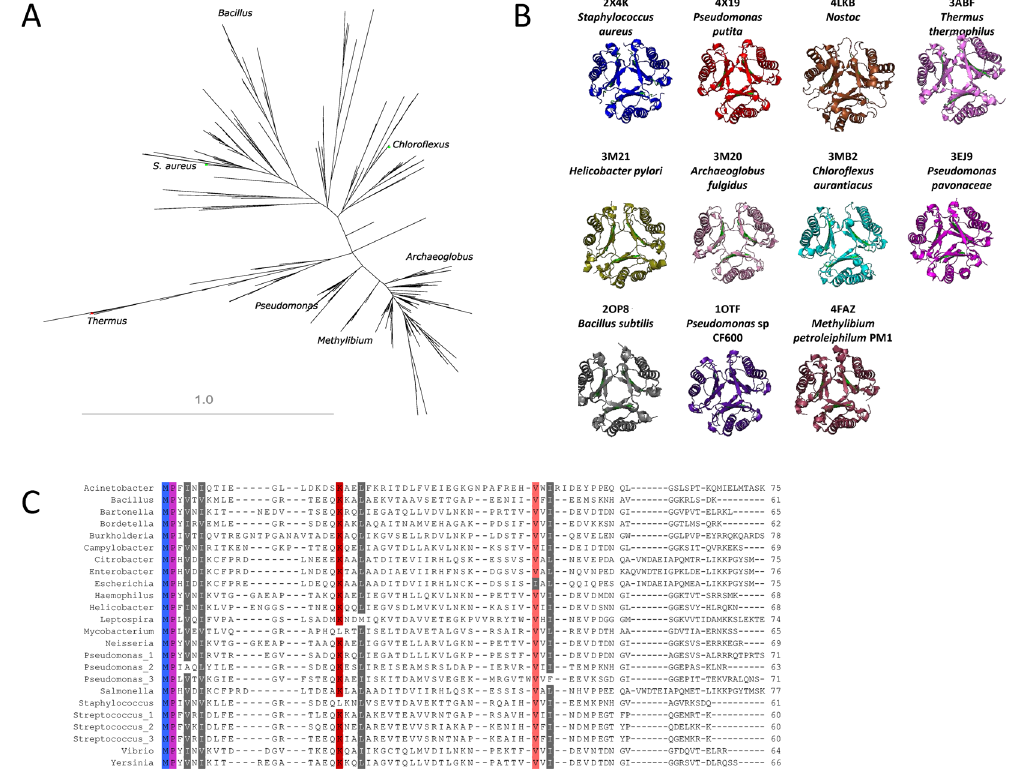
Figure 4. 4-OT family members. ( A ) Family tree, 2780 discrete family members (modal length of 63 amino acids) were found across Bacteria . ( B ) Despite the extensive primary amino acid sequence diversity